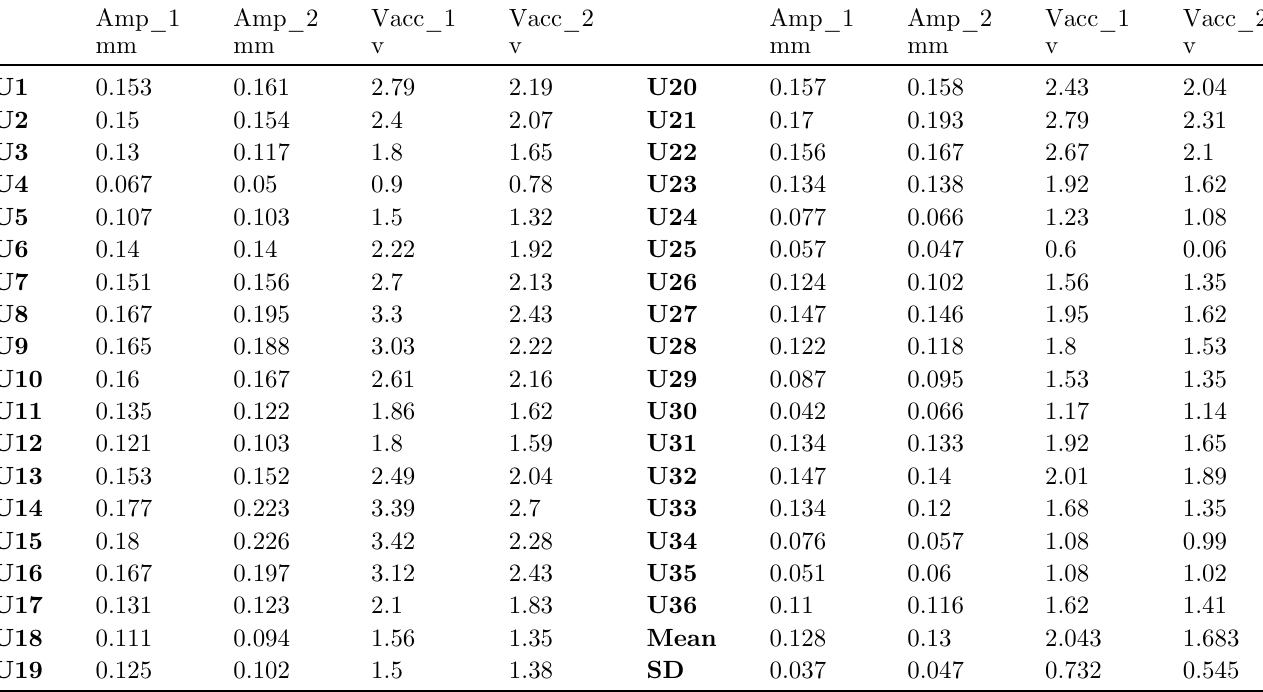
Table 5. Measured data of rotor responses with considering the uncertainties under 36 sets of unbalance loaded.